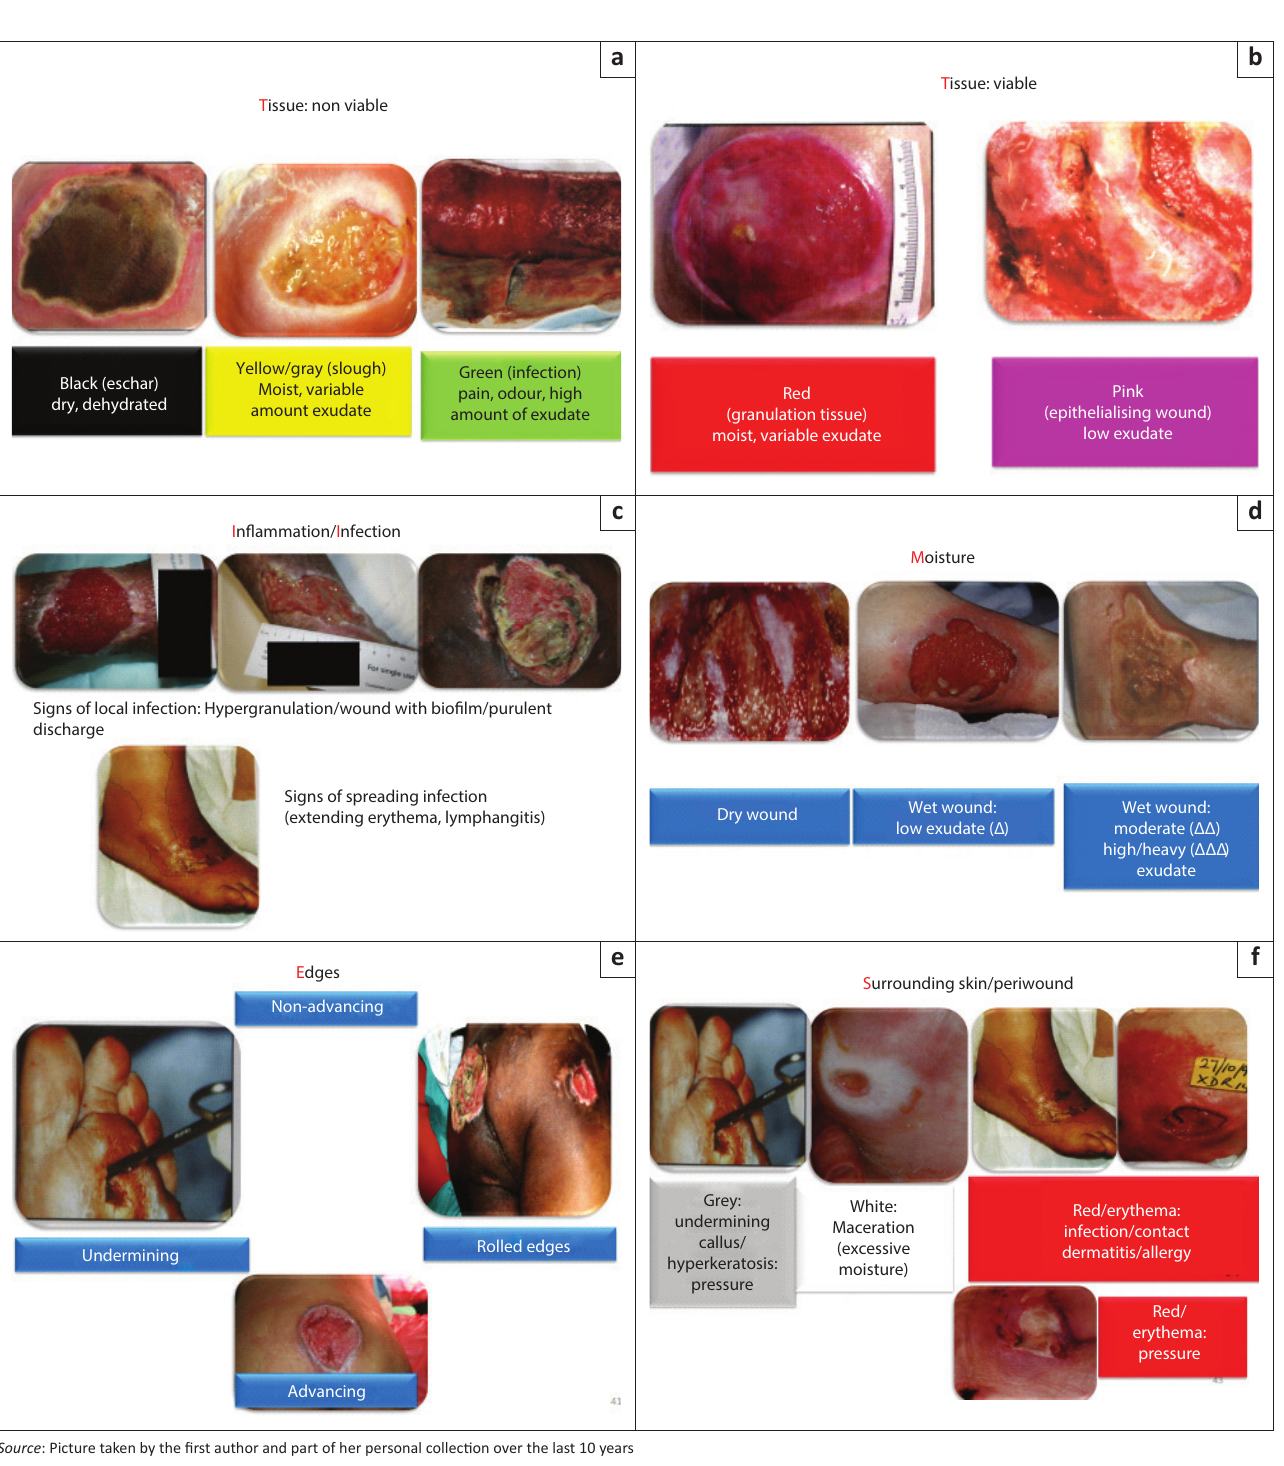
FIGURE 2: Pictures of examples of tissue (a, b, c), moisture (d), edges (e) and surrounding skin (peri-wound) (f) found in the TIME